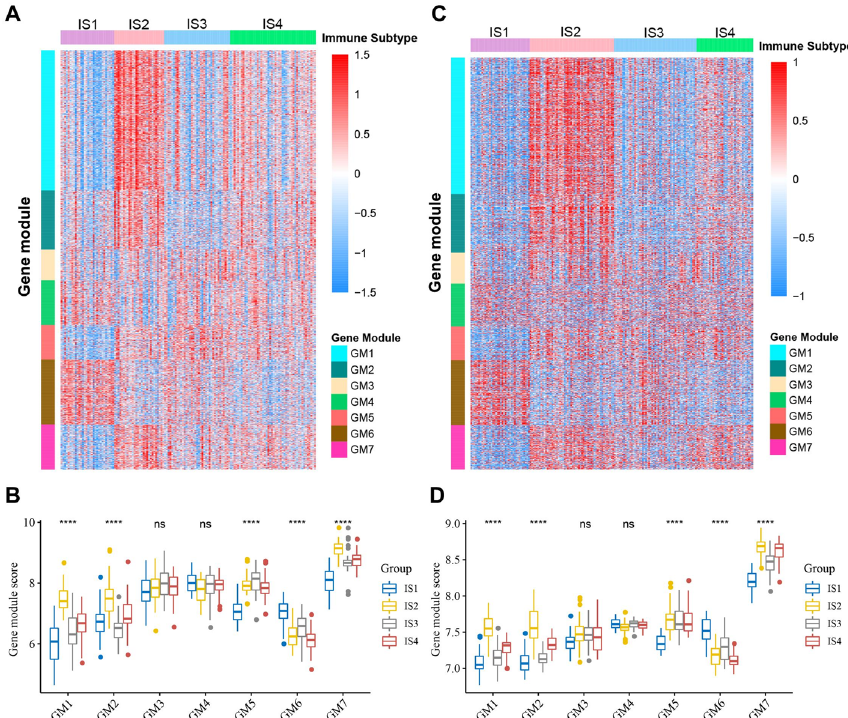
Fig. 7 Functional immune genes modules in GBM. Heatmaps of four immune subtypes and seven gene modules in the TCGA cohort ( a ) and the REMBRANDT cohort ( c ). Genes are ordered based on the gene modules, and patients are arranged based on their immune subtypes. Box plots of the expression patterns of seven gene modules of four immune subtypes in the TCGA cohort ( b ) and the REMBRANDT cohort ( d ). **** p <